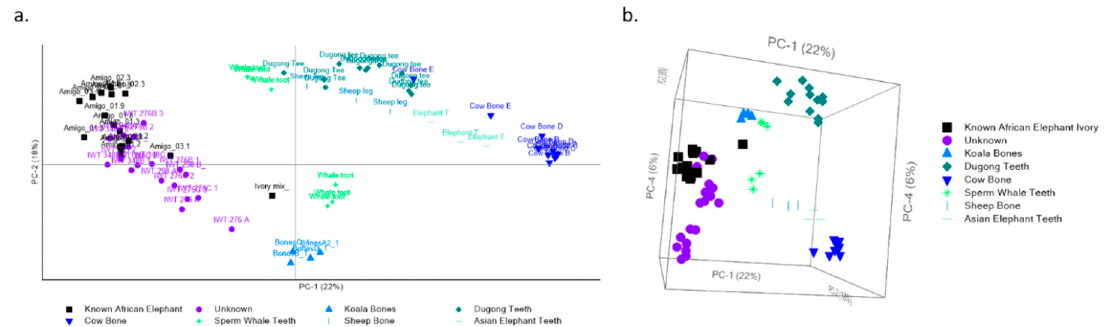
Figure 2. Principal component analysis of the known African elephant ivory, known outgroups and DoEE seizures with ( a ) showing PC1 and PC2 and ( b ) showing the 3D plot of PC1, PC2 and PC4. PCA analysis demonstrated that the majority of the sample groups could be distinguished from each other. The classifications were based on the four first principal components which accounted for a total of 55% of the variation in the data set. The Asian elephant tooth sample was found to form a cluster separately from the known African elephant derived ivory samples. None of the unknown seizures were found to cluster with the Asian elephant tooth, suggesting these samples were likely African